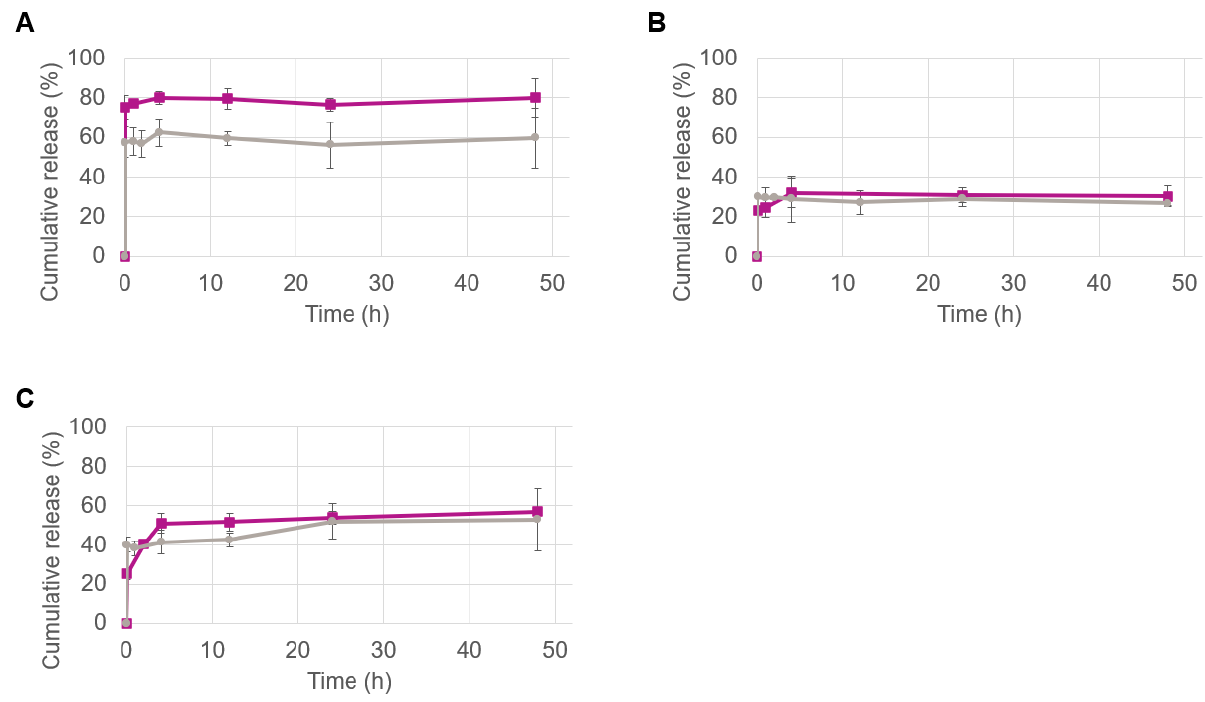
Figure 1. The cumulative release of the NY-ESO-1 peptide 1 ( A ), peptide 2 ( B ) and peptide 3 ( C ), from the PLGA nanoparticles obtained on an industrial scale (purple) and lab scale (grey) over time.